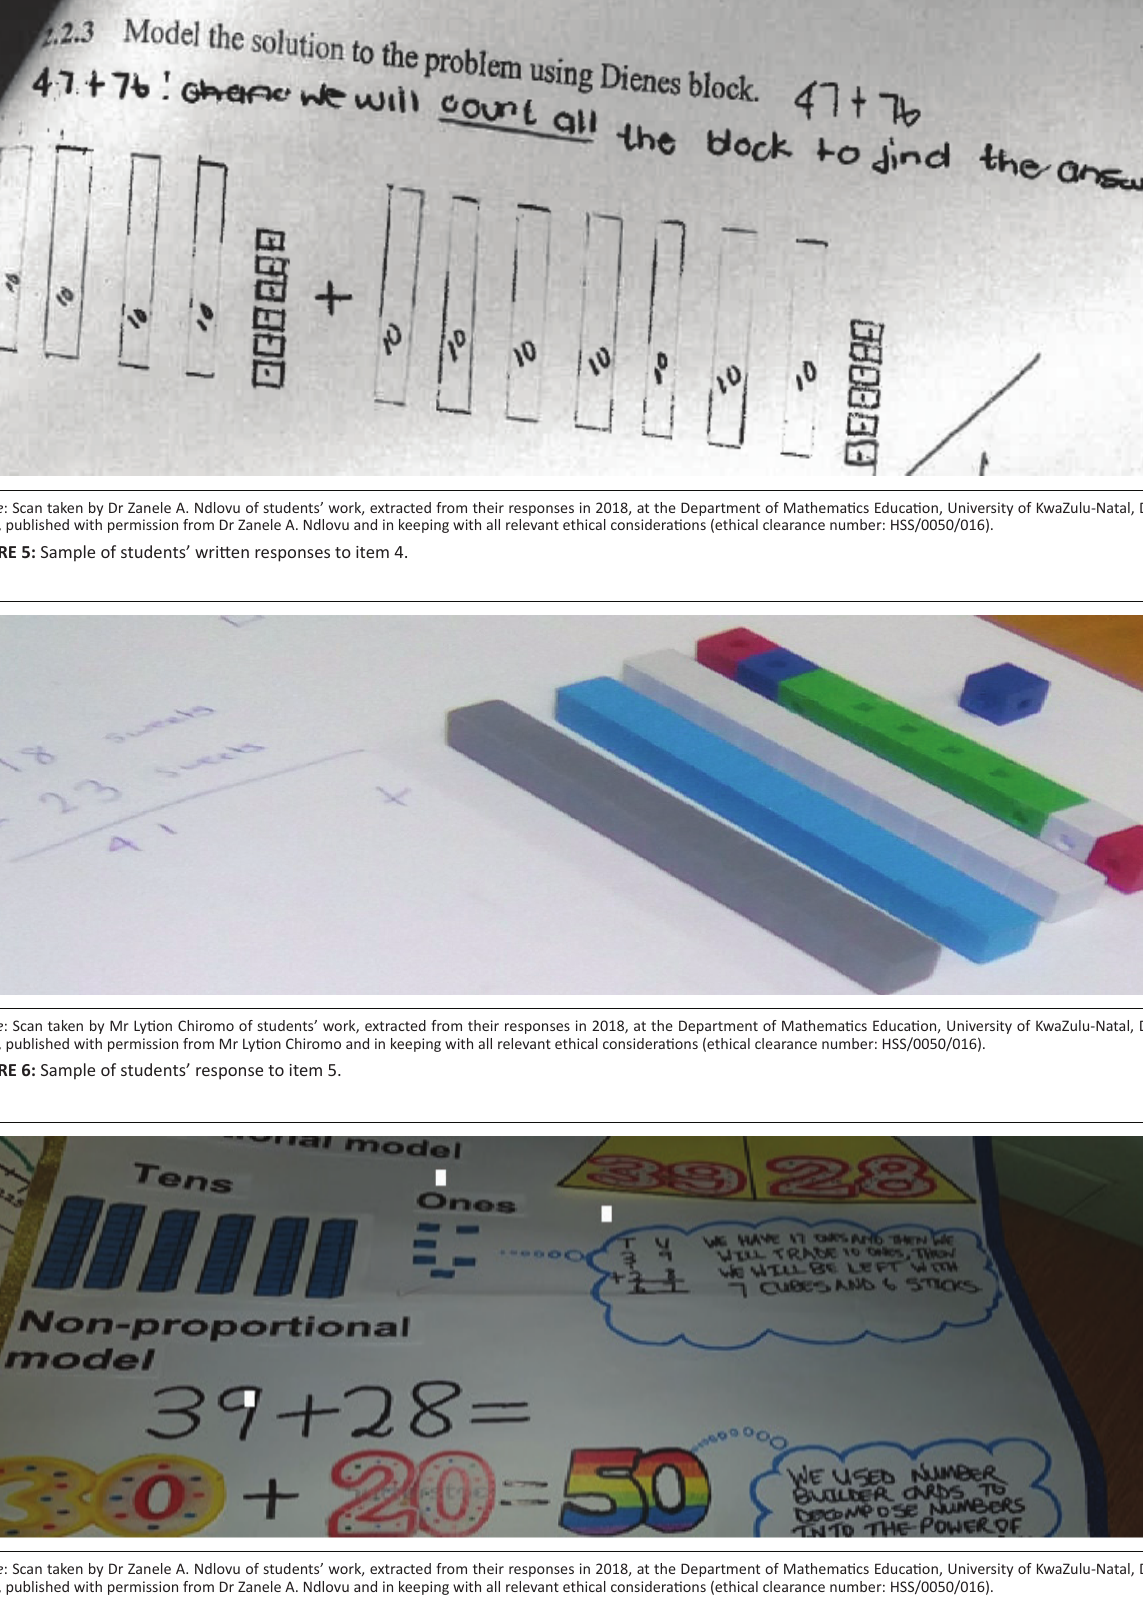
FIGURE 7: Sample of students’ response to item 6.